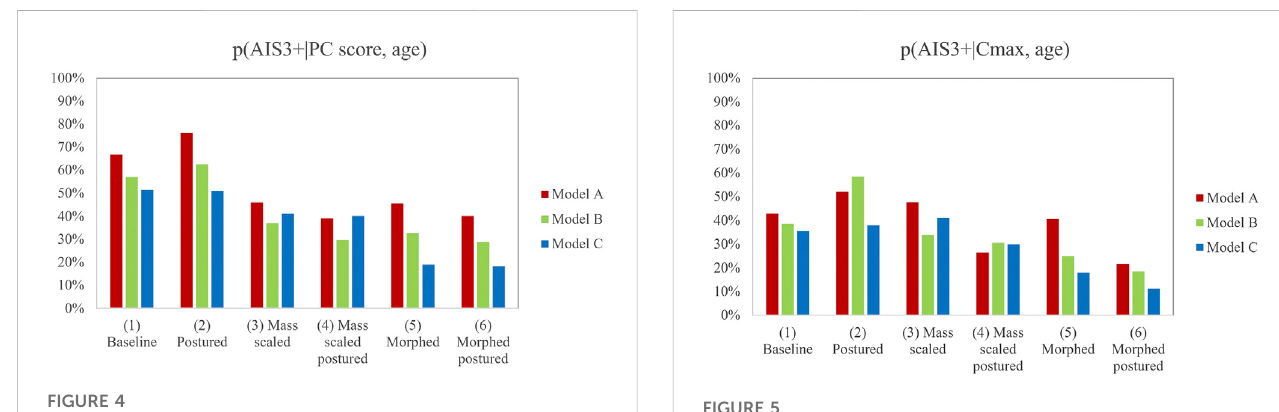
Probability of AIS3+ for the different model versions based on the Cmax metric. Note that there are 18 results to account for the differences in the position of the upper chest landmarks between PMHS A and B in the